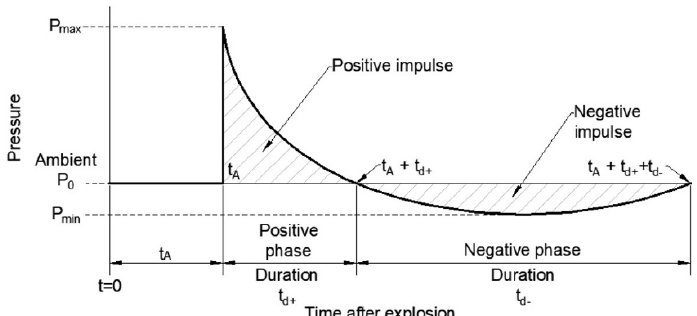
Figure 1. Typical scheme of a shock wave from an ideal explosion from a spherical source in an open environment [32] - adapted. Semi-empirical methods can be used for a preliminary overpressure analysis, those methods are related with scaled distance (Equation 3) that measures the effects of the explosion in terms of energy dispersion by relating the standoff distance with explosive mass.